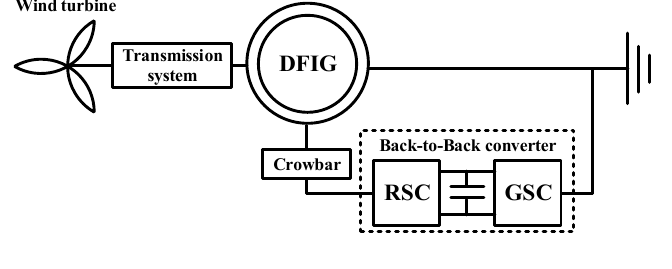
Figure 2. Detailed model of DFIG.